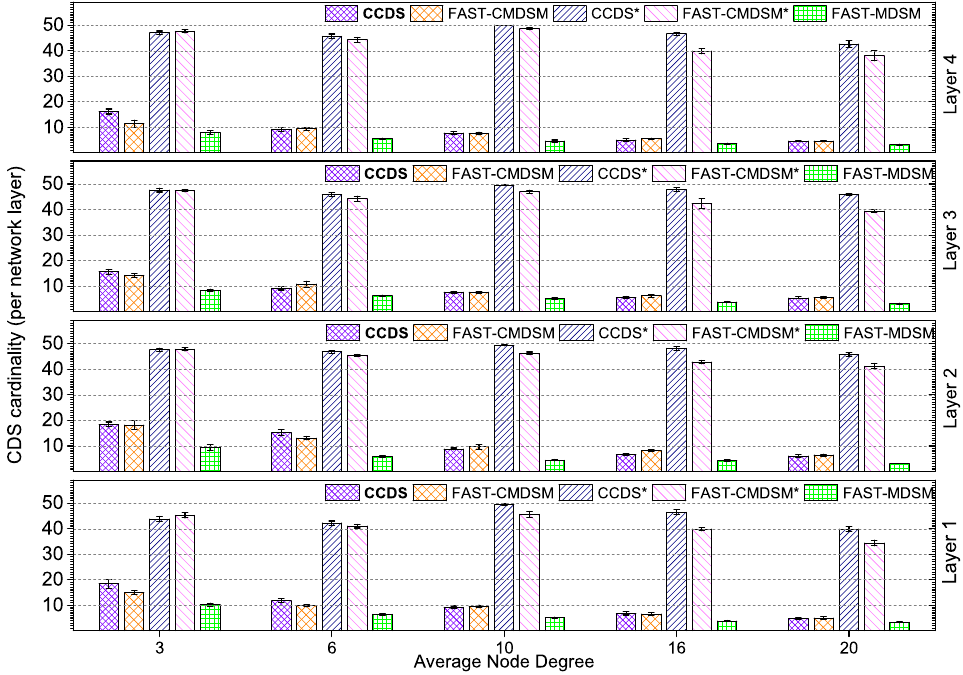
Figure 2. Impact of topology density (Medium